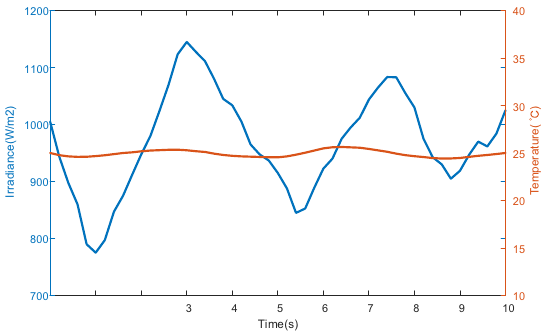
Fig. 10 Working condition design of PV system